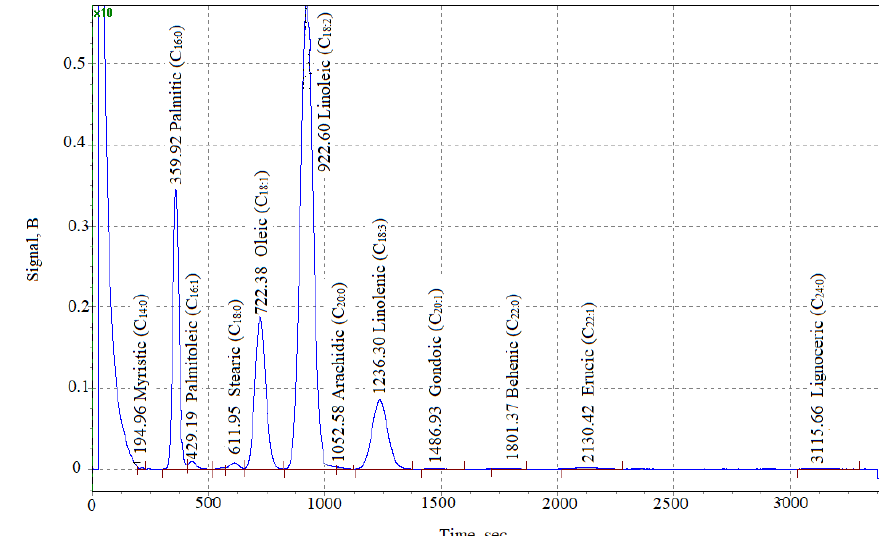
Fig. 1. Gas chromatogram of fatty acid composition in a lipophilic fraction of rye grains (Khamarka variety)